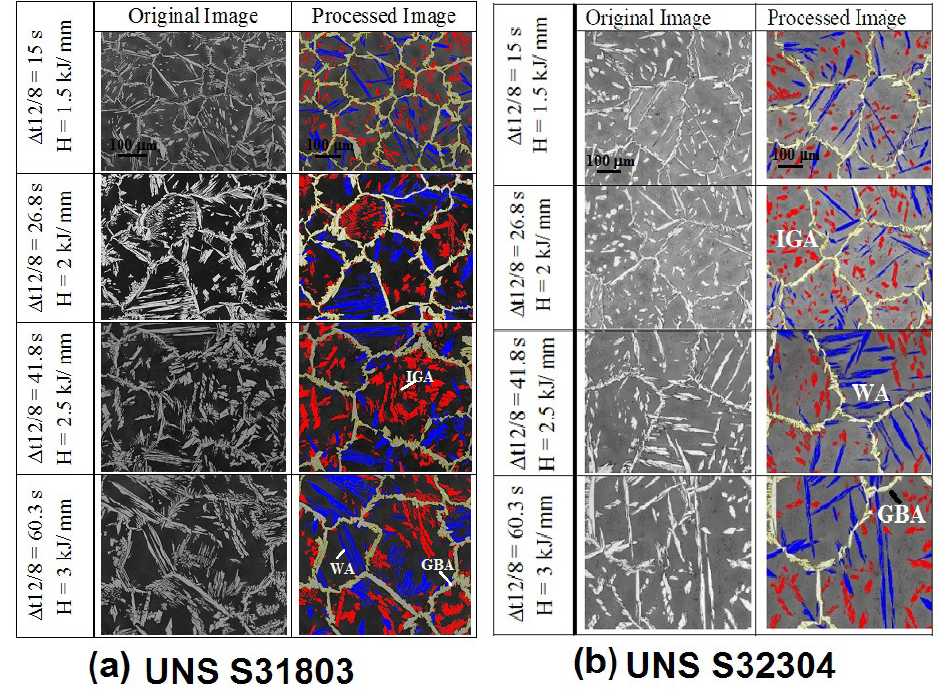
Figure 2. (a) Original and digital processed optical images of the simulated HAZs at different cooling times corresponding to the UNS S31803 DSS. (Morales et al. 19 ); (b) : Original and digital processed optical images of the simulated HAZs at different cooling times corresponding to the UNS S32304 DSS. ( In these digital processed images, the IGA particles are in red color, the WA laths are in blue color and the grain boundary austenite (GBA) is in white-grey color ).